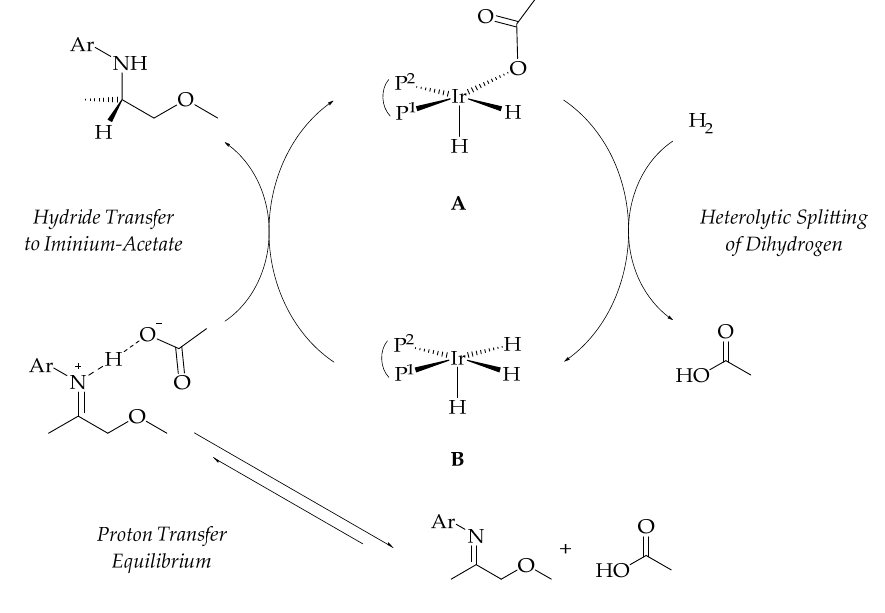
Figure 2. Outer-sphere mechanism without κ 2 -substrate coordination to iridium (this